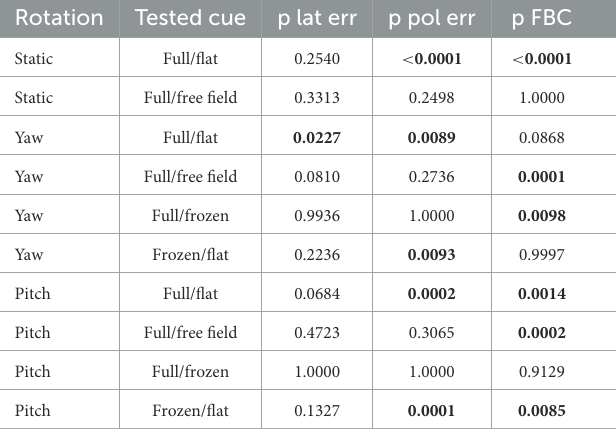
TABLE 2 Statistical significance of differences in three localization performance metrics (lateral error, polar error, FBC rate) between the tested acoustic cues, grouped by the type of head